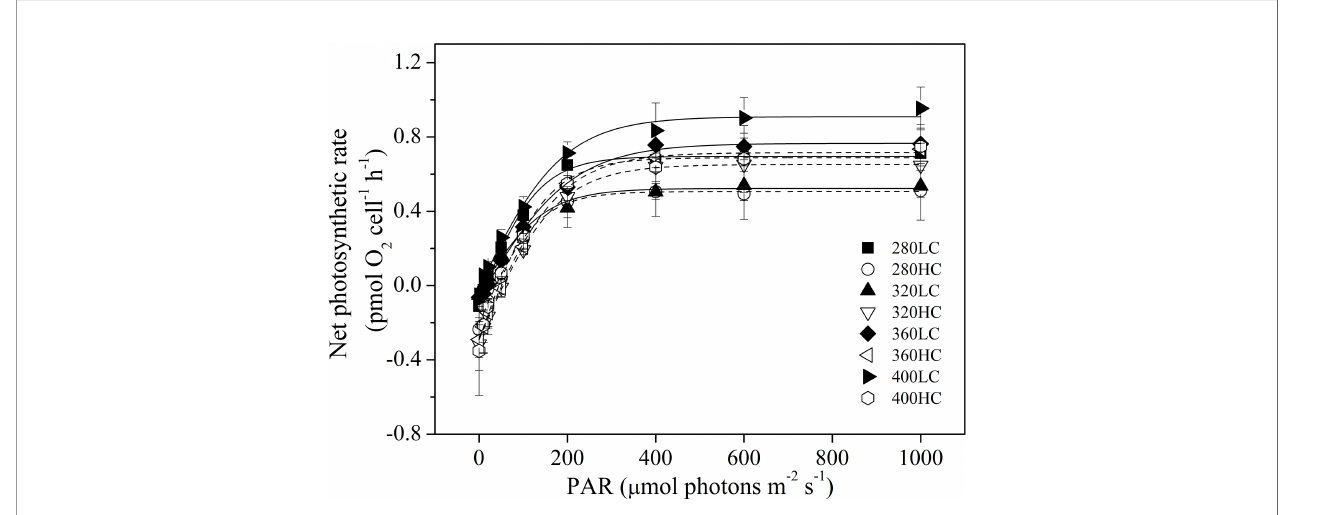
FIGURE 8 | Photosynthesis-light curves (P-I curves) of S. costatum acclimated to ambient (LC, black bars) and elevated CO 2 (HC, white bars) in different spectral